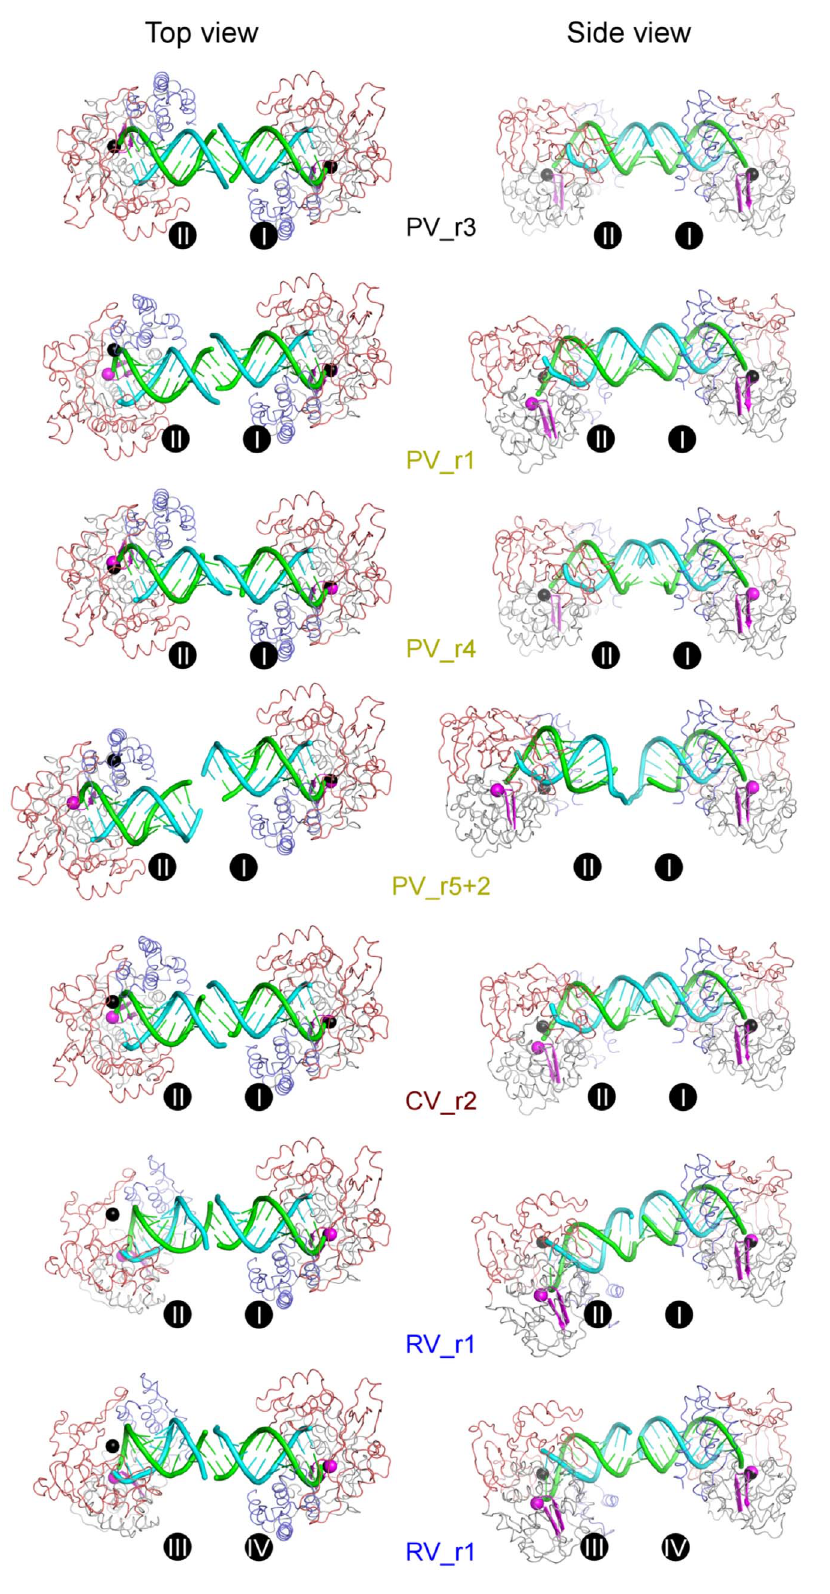
Figure 3. A comparison of inter-complex RNA-RNA junctions. Cartoon representations of seven EC pairs depicting the variety of inter- complex junctions observed in the crystals. The right side polymerase within each pair is always shown in the same orientation. The polymerases and RNA follow the color-coding scheme from Figure 1 with the YGDD residues of conserved motif C colored in magenta to help locate the polymerase